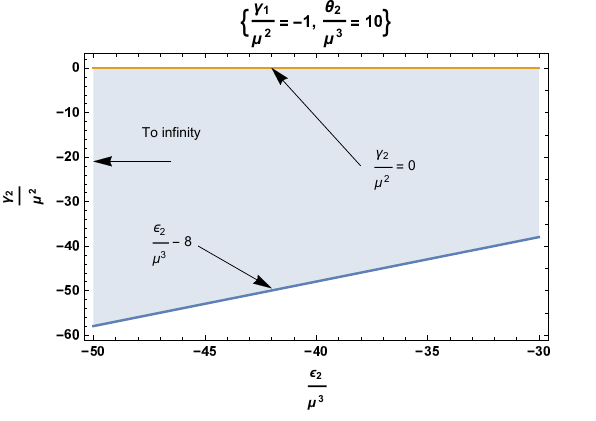
Figure 5 . Phase space of transports ˜ γ 2 and ˜ ǫ 2 for ˜ γ 1 = are derived from Routh-Hurwitz and stability